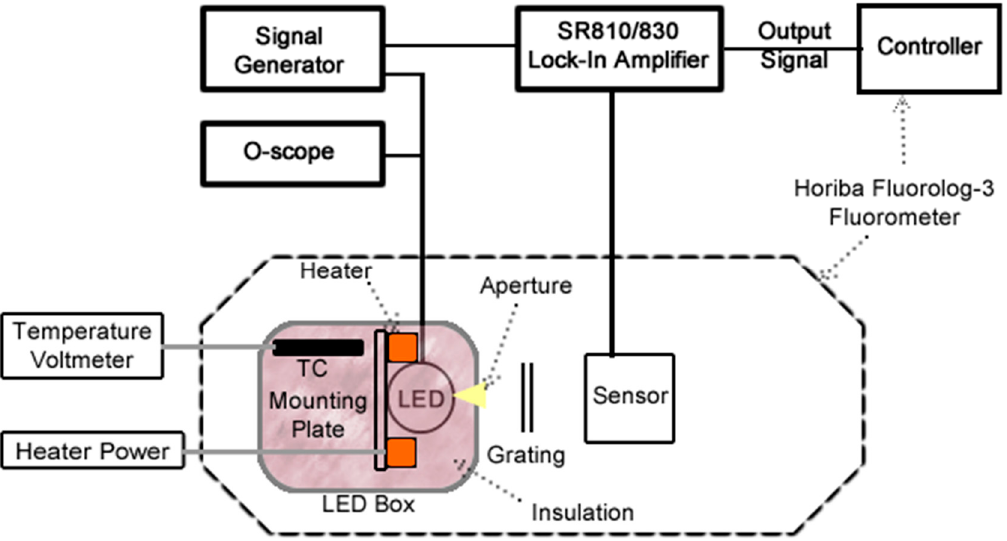
Figure 2. Test Apparatus schematic, showing major component and connections. LED emits light through LED Box Aperture, which then falls upon the Fluorometer sensor for measurement.